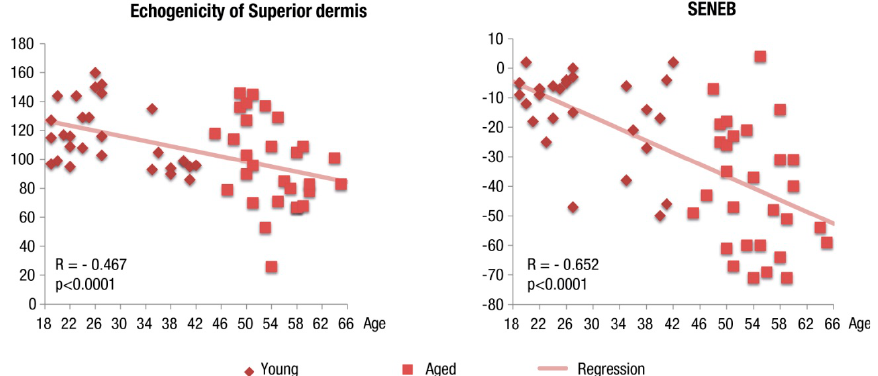
Figure 7. Evolution of echogenicity and SENEB with aging. The regression line shows the parameters as a function of age. R = Pearson coefficient of correlation, p value indicates the significance level of